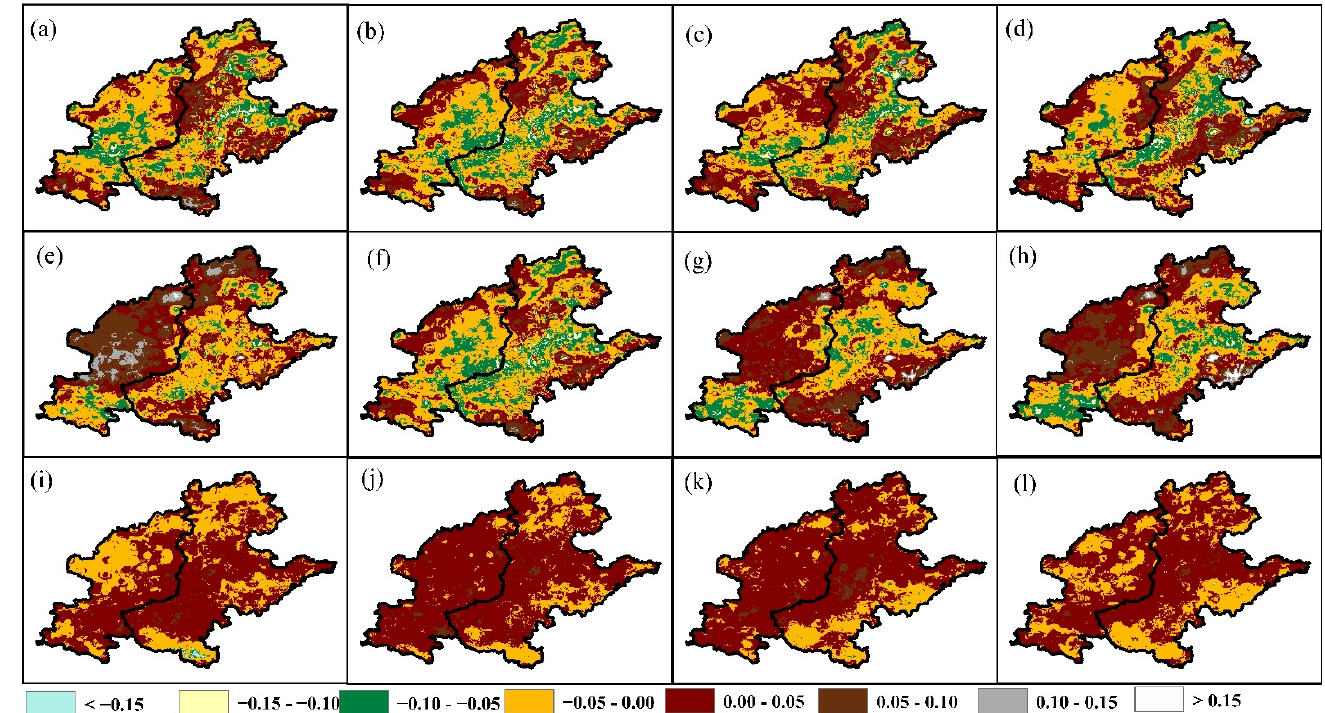
Figure 13. Spatial distributions of the frequency difference of the SPEII6 moderate drought